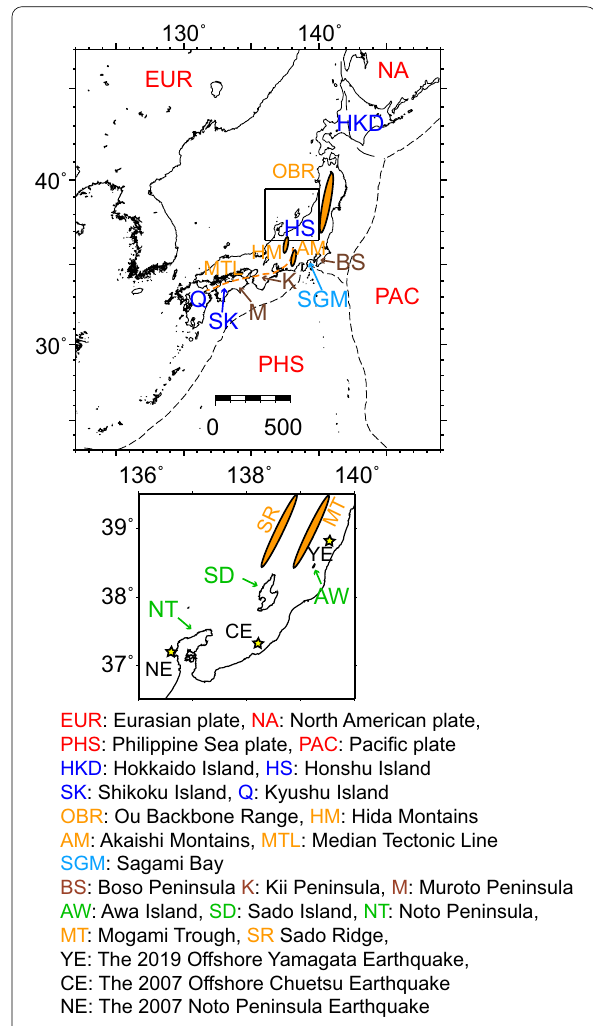
Fig. 1 Tectonic setting around Japanese Islands and the central coast of Sea of